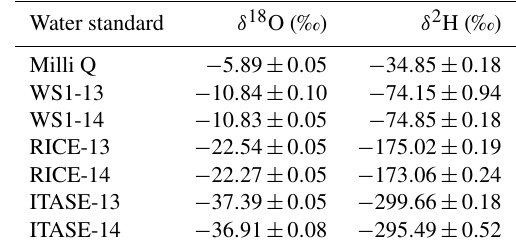
Table 1. Accepted values (VSMOW-SLAP scale) for water stan- dards used for calibrations in per mil